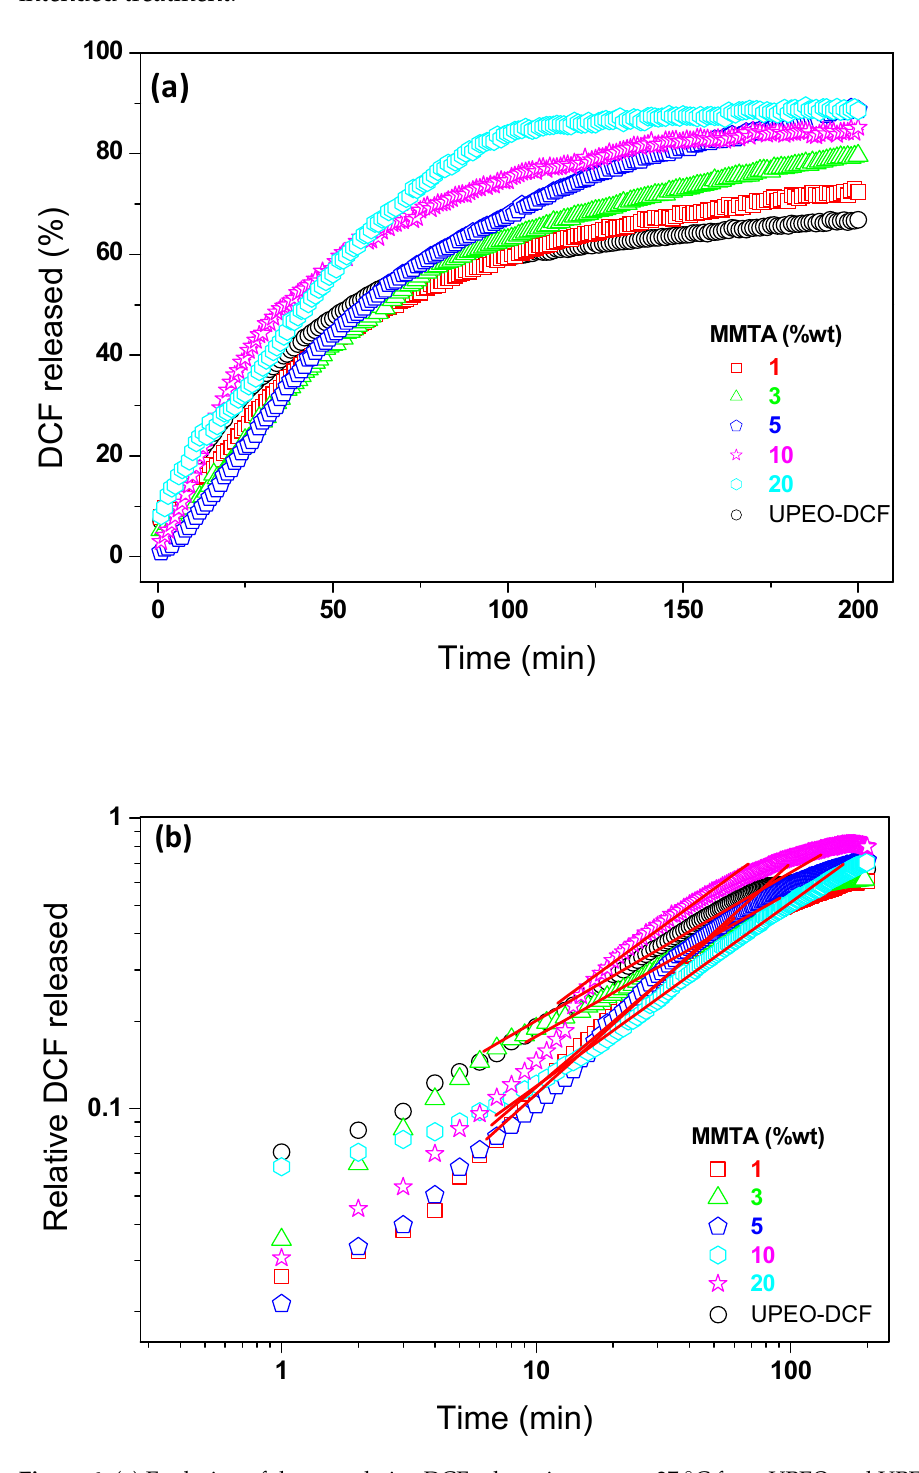
Figure 6. ( a ) Evolution of the cumulative DCF release in water at 37 °C from UPEO and UPEO-MMT nanocomposites containing 1, 3, 5, 10, 20% of MMTA and ( b ) Relative DCF release (see Equation (1)), plotted as log ( Mt/M ∞ ) as a function of log t, from UPEO and UPEO–MMTA. The DCF loaded amount was maintained at 5% wt for all samples.